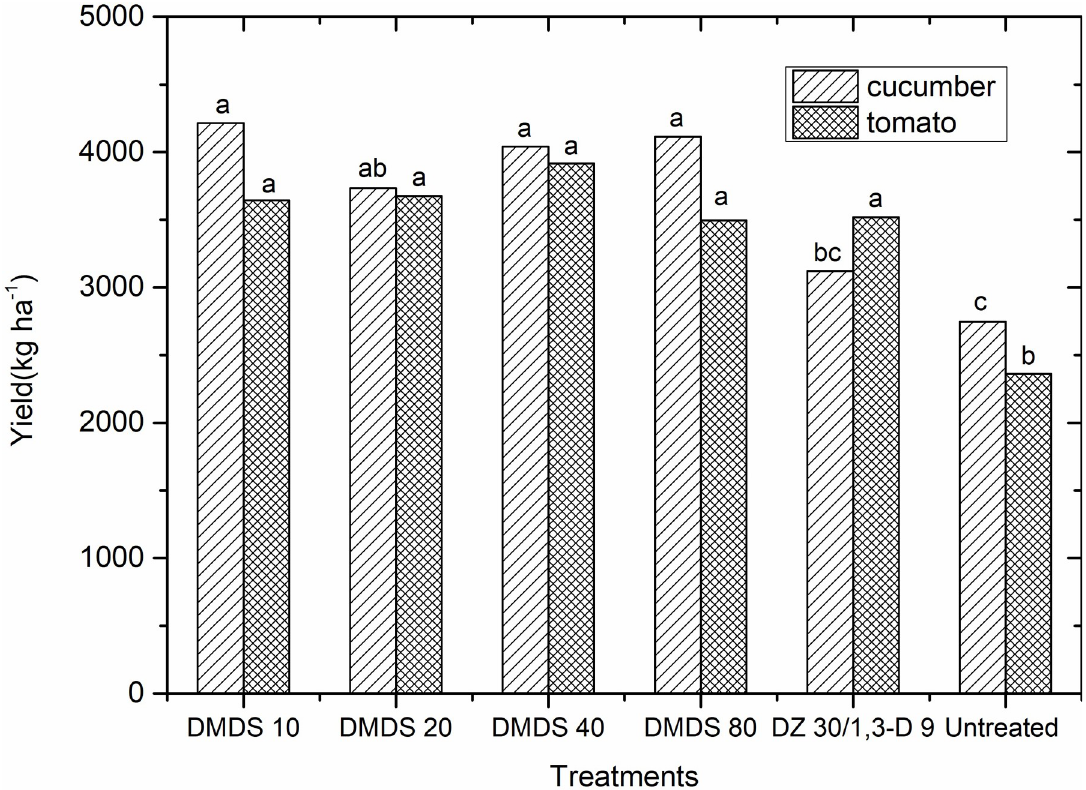
Fig 1. Cucumber and tomato yields after different fumigation treatments in the year 2014. Abbreviations: DMDS = dimethyl disulfide, 1,3-D = 1,3-dichloropropene, DZ = Dazomet, DMDS 10 = DMDS 10 g m -2 treatment, DZ 30 = DZ 30 g m -2 treatment of cucumber trials in the year 2014, 1,3-D 9 = 1,3-D 9 g m -2 treatment of tomato trials in the year 2014. Different letters indicate significant differences in each treatment group according to the LSD